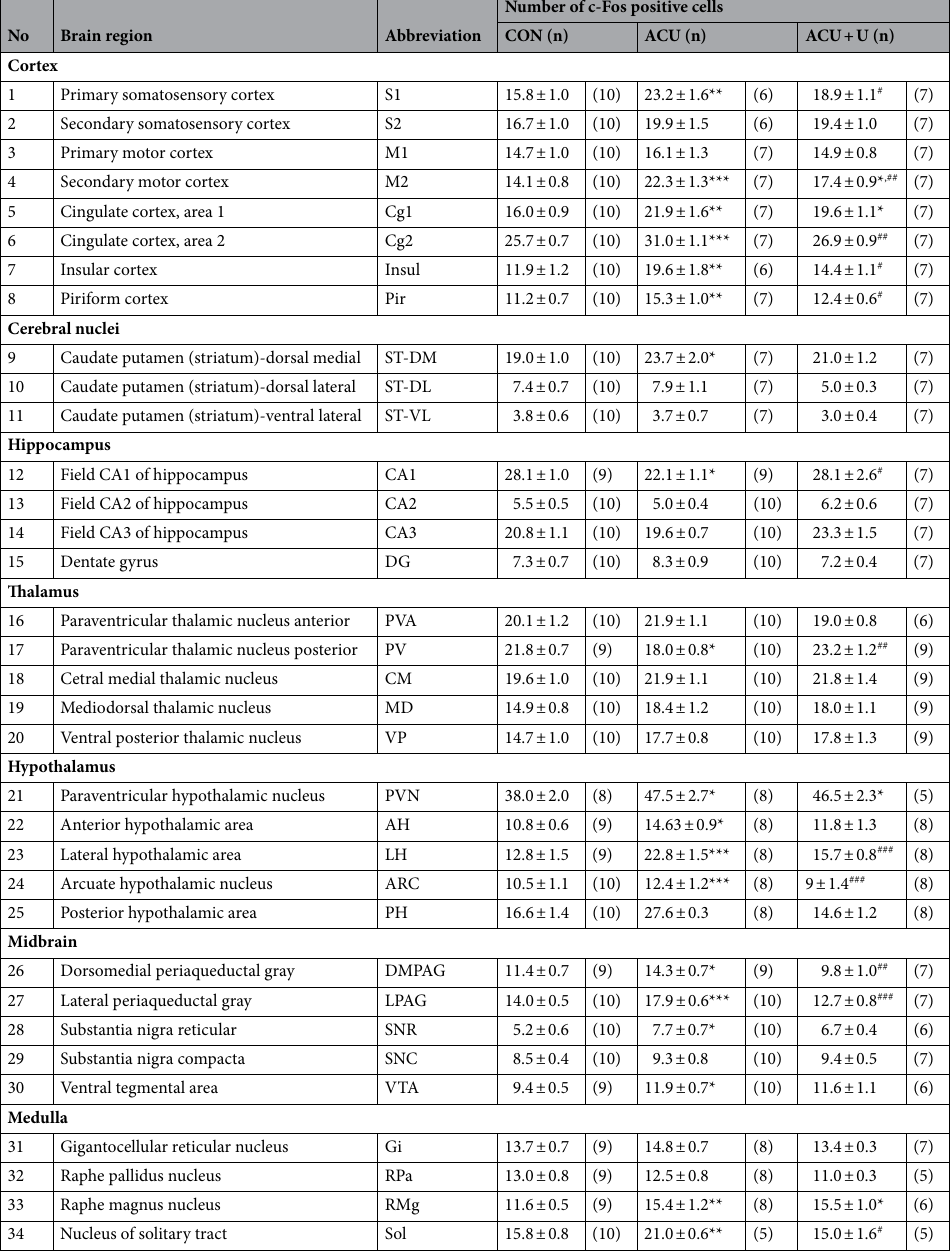
Table 1. Abbreviations of brain regions and the number of c-Fos-positive cells in each brain region. Thirty- four brain regions for c-Fos quantification. Brain regions are categorized by major brain subdivisions. * P < 0.05, ** P < 0.01, *** P < 0.001 compared to the CON group. # P < 0.05, ## P < 0.01, ### P < 0.001 compared to the ACU group. CON control, ACU acupuncture treatment, ACU + U U0126 administration followed by acupuncture treatment, n number. One-way ANOVA was followed by the Newman–Keuls post-hoc test. Data are expressed as the mean ±